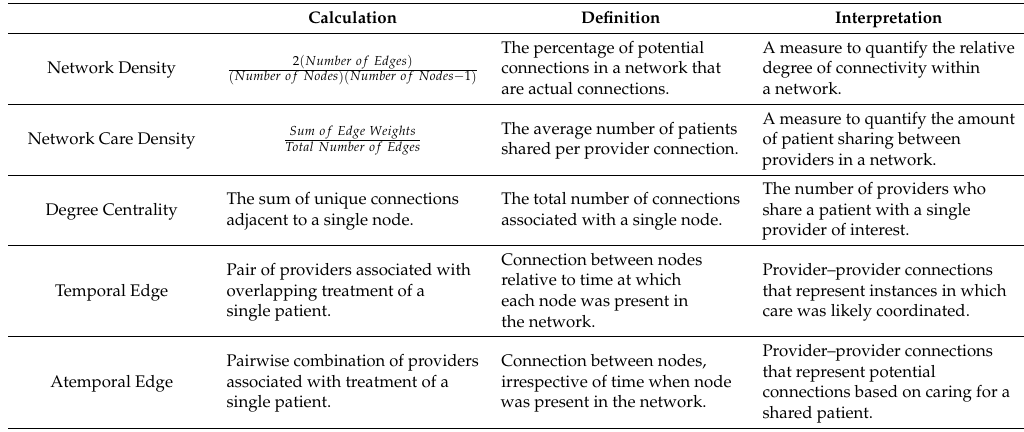
Table 1. Network analysis measures.